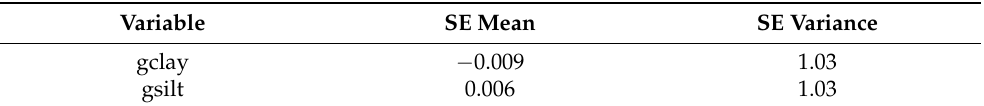
Table 5. The cross-validation results of the two variables (gclay and gsilt) in the data fusion process. Variable SE